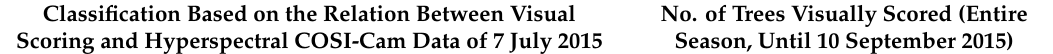
Table 3. Comparison of the true / false positive and negative classification based on the 7 July 2015 visual and hyperspectral COSI-cam data (Table 2) and the visual scoring over the entire season till September 10, 2015 as fire blight infected (FB), healthy or other symptoms (i.e., incompatibility with the rootstock or symptoms resembling fire blight). Classification Based on the Relation Between Visual No. of Trees Visually Scored (Entire Scoring and Hyperspectral COSI-Cam Data of 7 July 2015 Season, Until 10 September 2015) Class No. of trees FB* infected Healthy Other True positive 108 107 1 0 True negative 126 86 27 13 False positive 110 82 11 17 False negative 66 66 0 0 * FB = fire